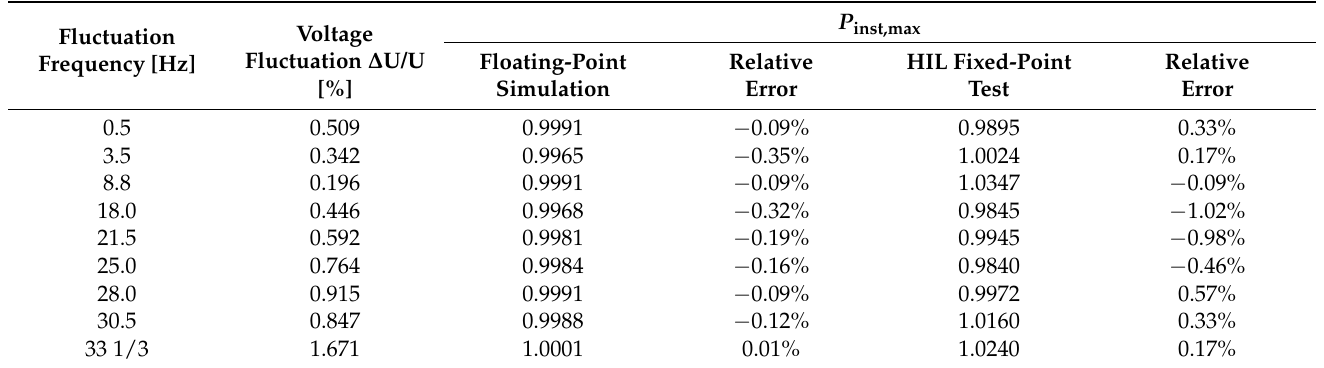
Table 3. Response to rectangular voltage fluctuations.